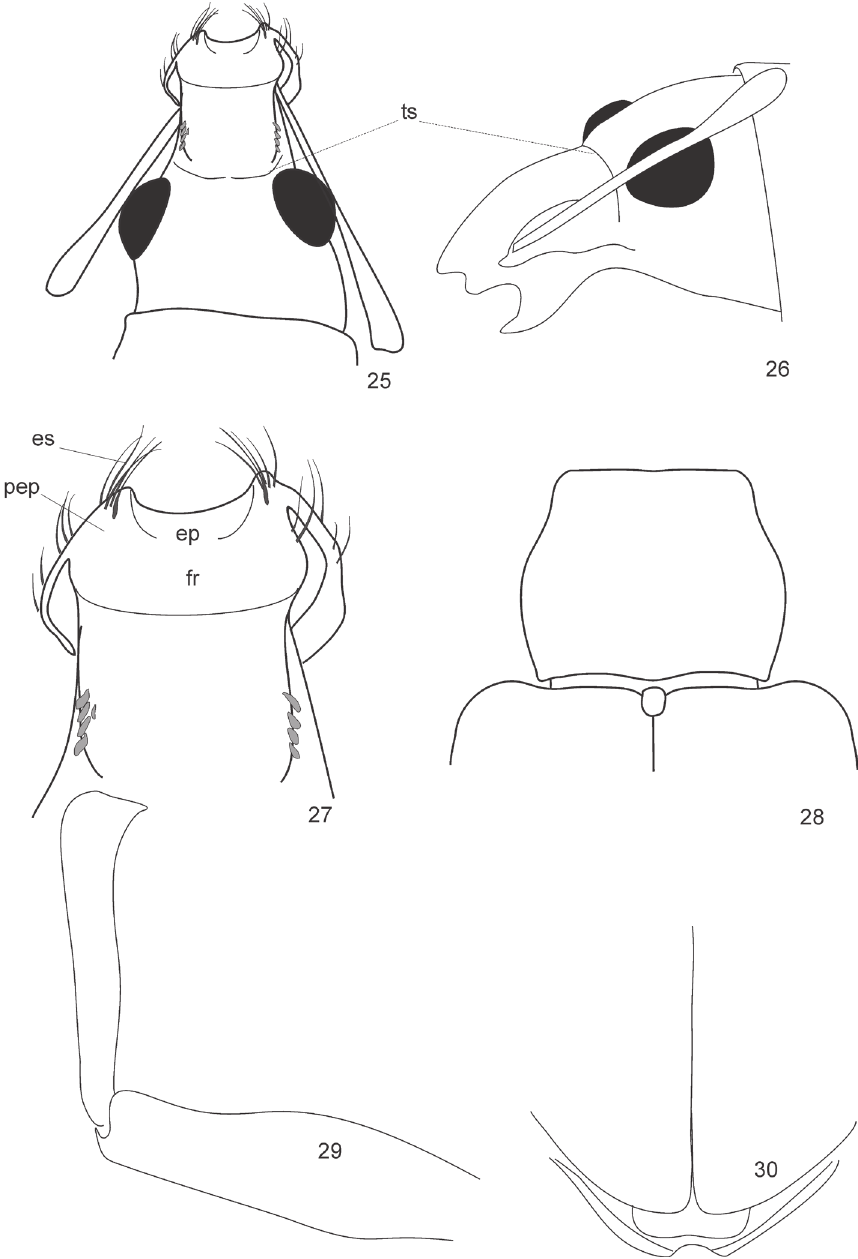
Figures 25–30. Protonaupactus sobrinus (Voss, 1972), holotype, male. 25 head with antennal scape, dor- sal view 26 idem, lateral dorsal view 27 epistomal area of rostrum 28 pronotum and elytral base, dorsal view 29 anterior right leg, dorsal view 30 elytral apex with pygidium and anal ventrite. Abbreviations: ts transverse sulcus, es epistomal serae, ep epistome, fr frons, pep parepistome. Scale bar: 1 mm (Figs 25, 26, 28, 30); 0.5 mm (Figs 27, 29